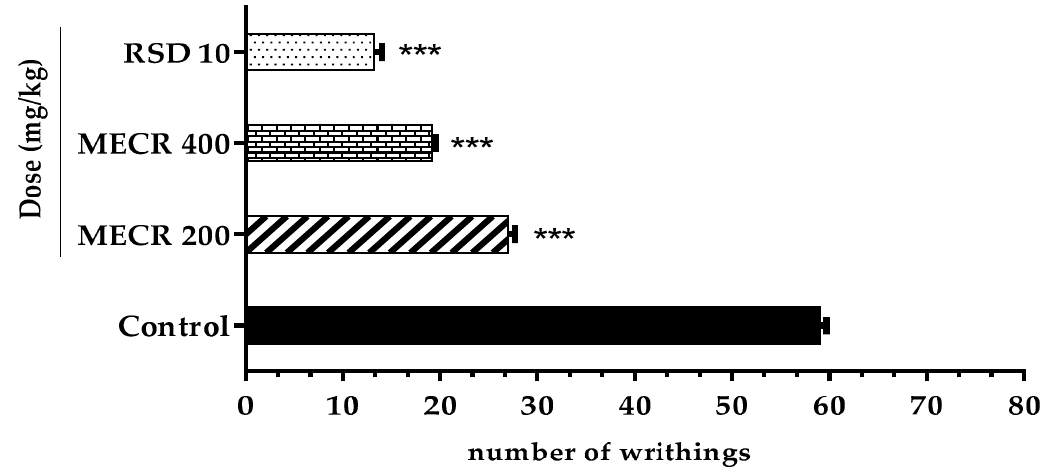
Figure 5. The effect of methanol extract of Cuscuta reflexa (MECR) in acetic acid-induced writhing test in mice. Values are expressed in mean ± SEM (n = 6). ***p < 0.001 compared to control (Dunnett’s test). RSD: reference standard drug (Diclofenac sodium, 10 mg/kg).